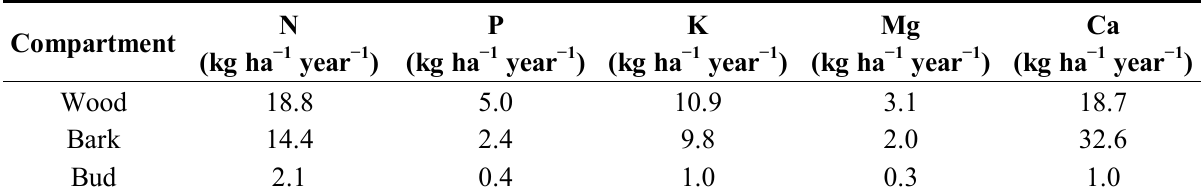
Table 8. Estimated elemental content in above ground biomass of a three-year-old poplar